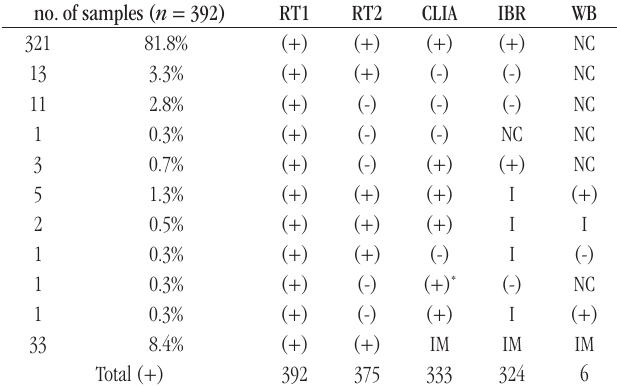
taBLE 3 − Profile of the results of the 392 reagent samples in RT1 evaluated in conventional